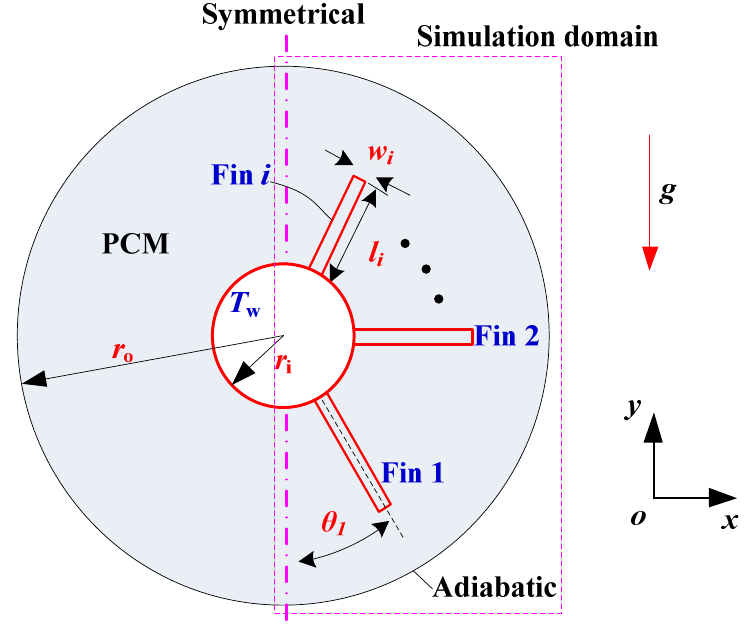
Figure 1. Physical model for present